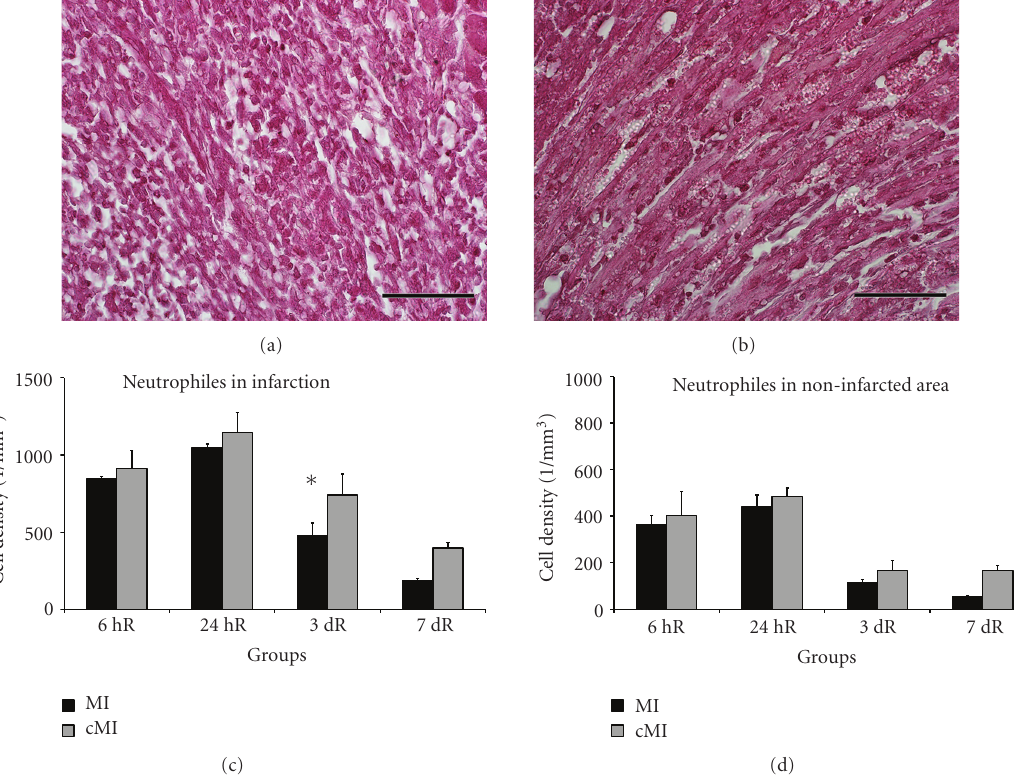
Figure 2: Neutrophils density in injured myocardium. Representative MCA 771 G staining for neutrophils (black-stained cells) in infarcted left ventricular wall (pink eosin counterstaining) 3 days after (a) reperfused infarction (MI) and (b) cryoinfarction (cMI). Comparison of neutrophils cell density in (c) infarcted area and (d) noninfarcted area in both models. Scale bar: 75 μ m; ∗ P < .